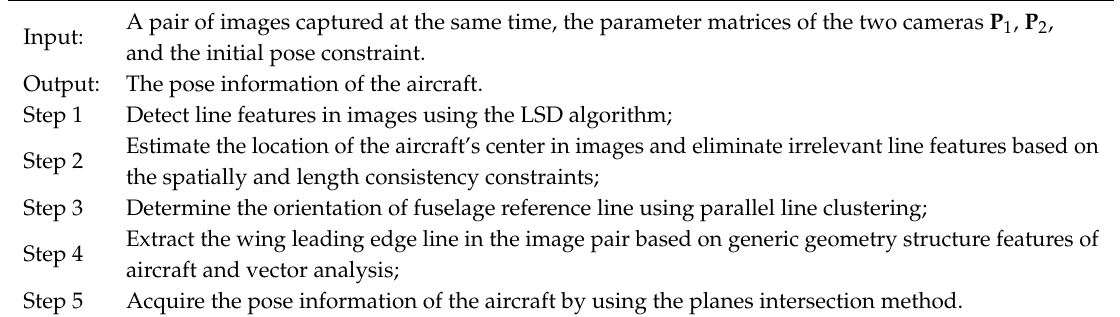
Algorithm 1. Pose estimation based on geometry structure features and line